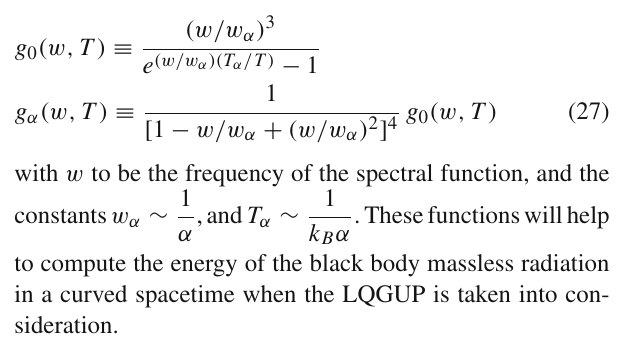
Fig. 3 The effect of different weight factors on the calculation of the number of states upon considering LGUP, QGUP and LQGUP in D = 3. We have set α = 1